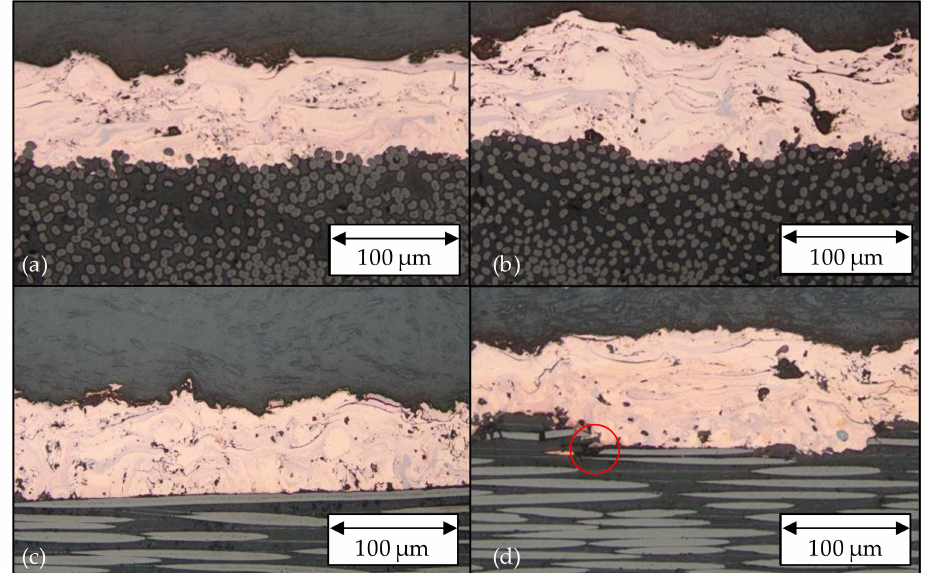
Figure 10. Cross-sections of wire arc copper coated CFRP with different surface pre-treatments and highlighted air pocket by red circle ( a , b ): longitudinal to fiber orientation of laser roughening and grit blasting; ( c , d ): transversal to fiber orientation of laser roughening and grit